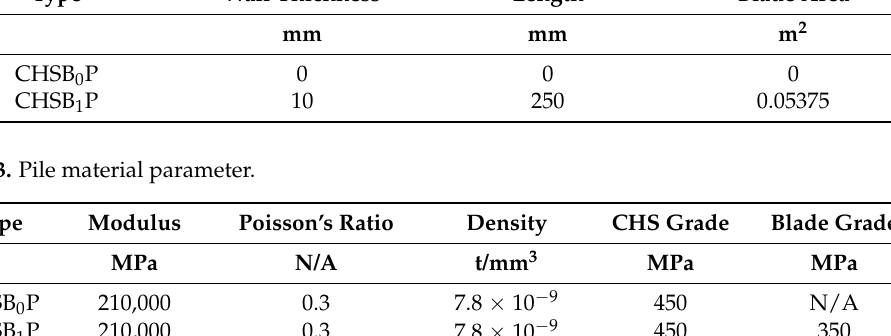
Table 2. Blade geometry parameter.